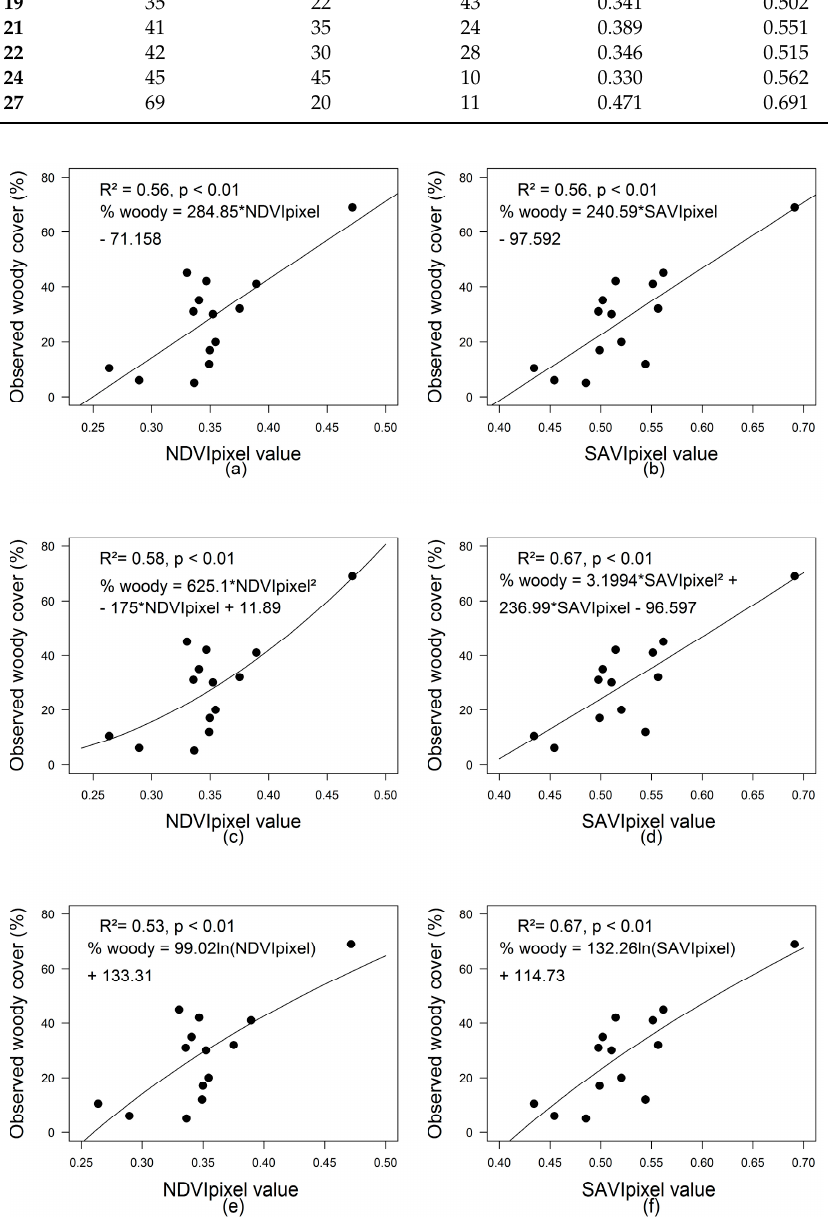
Figure 4. The relationship between NDVIpixel, SAVIpixel and field percent cover estimates with regression analyses, simple linear ( a and b ), polynomial ( c and d ) and nonlinear regression ( e and f ). 3.1.2. NDVI and SAVI for Woody Cover Estimation with NDVI soil Determination Using a Modified Procedure by Zeng et al. [34] and Wu et al. [35]